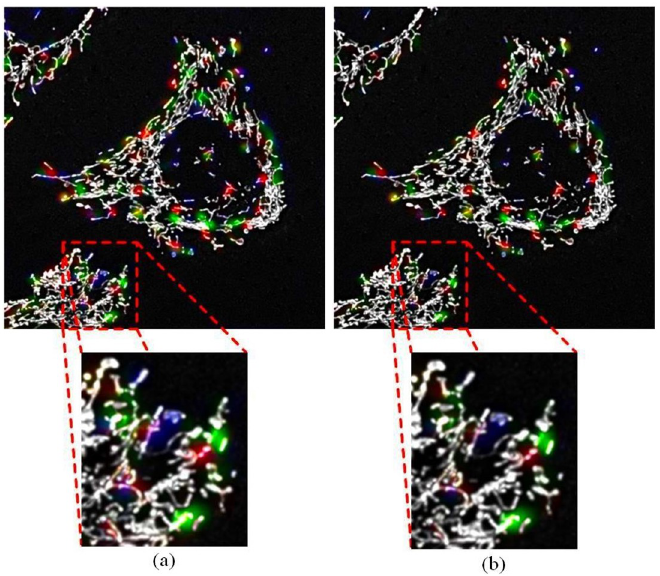
Fig 6. The output of the three-dimensional Pix2Pix GAN after training. (A) The output initial training with the clean dataset for 545 epochs and (B) then after training with the complete dataset for an additional 25 epochs to reduce noise artefacts. After this noise reduction training process, the random colour fragments were reduced, as illustrated within the enlarged red rectangles. During validation, the two green kernels on the right of the enlarged z-stacks are counted as predicted fusion events.